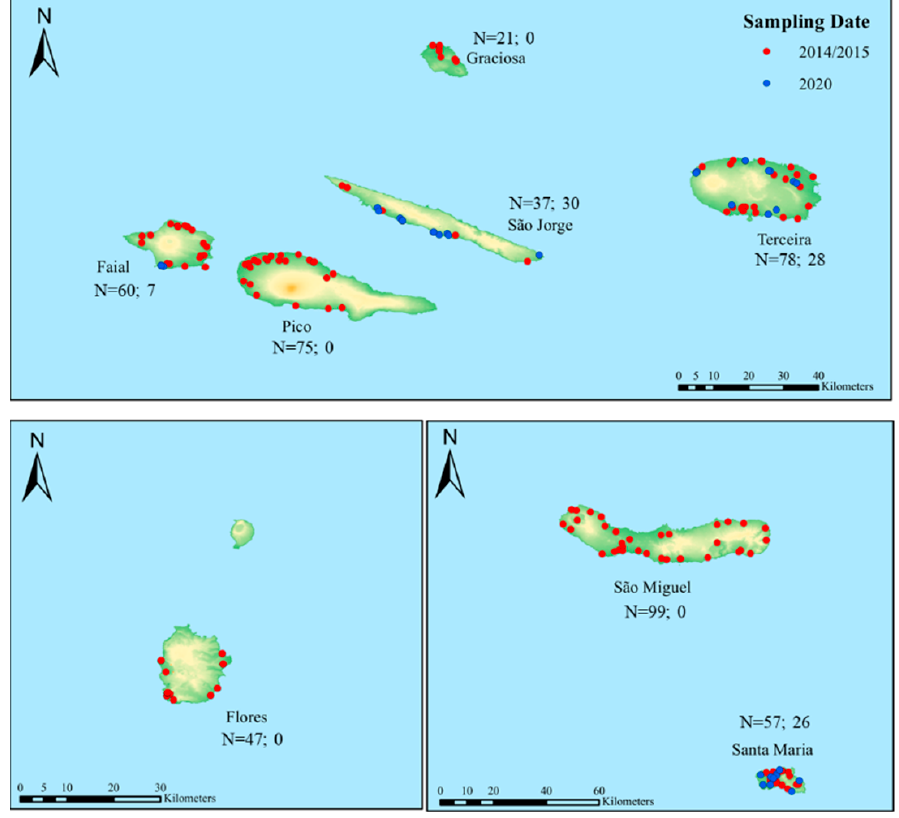
Figure 1. Geographic distribution of the apiaries sampled in 2014/2015 (red dots) and 2020 (blue dots) across the Azores. N is the number of colonies sampled in 2014/2015 ( left ) and 2020 ( right ). Table 1. Sample sizes and climate data for the 2014/2015 and 2020 sampling periods. Islands with V. destructor are represented in